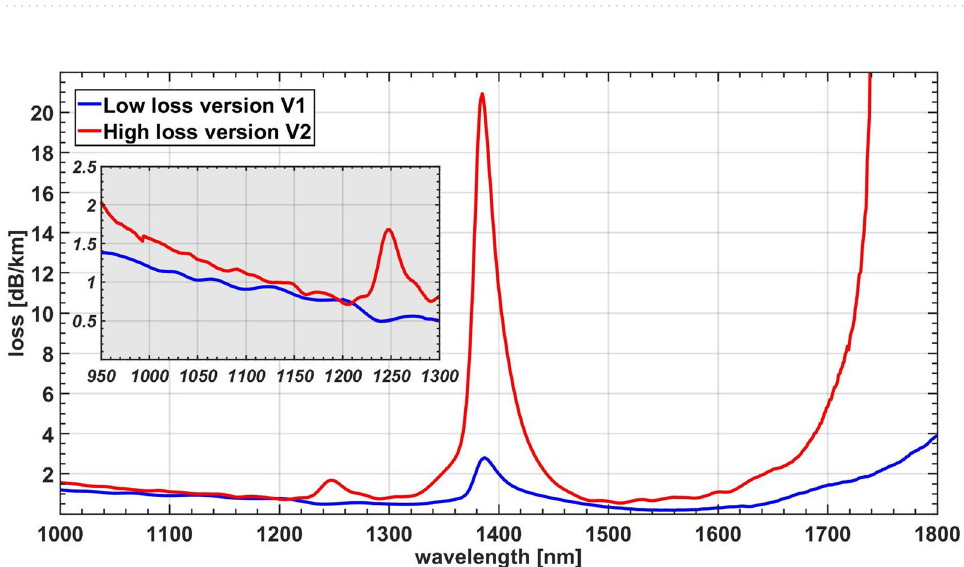
Figure 4. Attenuation as a function of wavelength for the two versions of Corning’s HI1060 fiber. The inset highlights the region of the laser